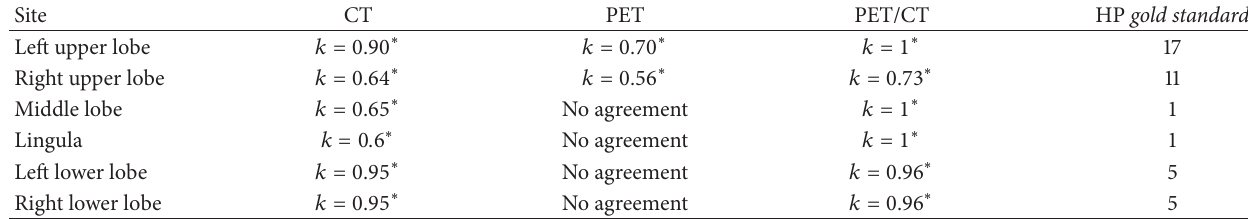
Table 4: Concordance of each diagnostic technique with the “T” of the surgical patients.